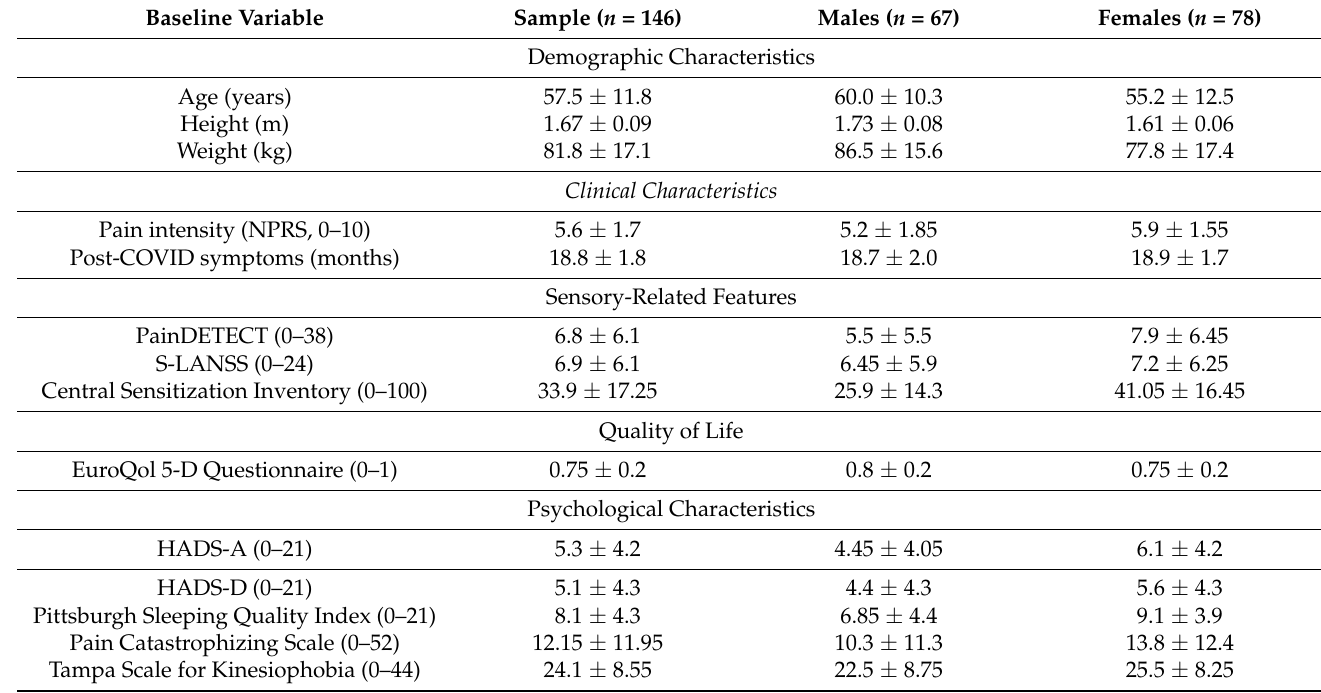
Table 1. Baseline outcomes (mean ± SD) of the sample.